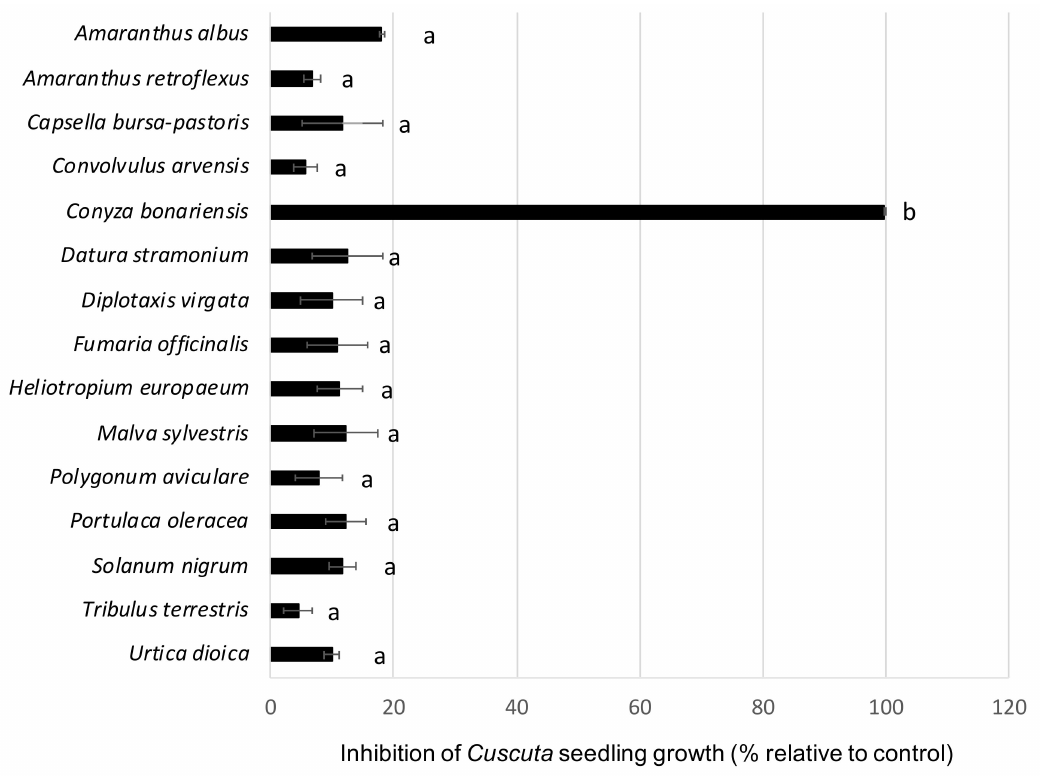
Figure 1. Allelopathic effects of dichloromethane extracts of fifteen weed species on growth of Cuscuta campestris seedlings expressed as percentage of inhibition compared to the control. Bars with different letters are significantly different using the Tukey test ( p = 0.05). Error bars represent the standard error of the mean.